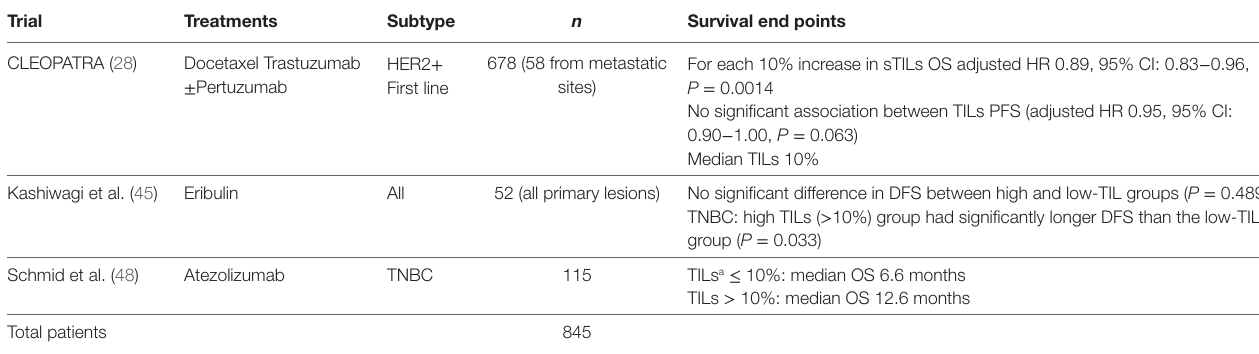
TABLe 4 | Tumor-infiltrating lymphocytes (TILs) in metastatic